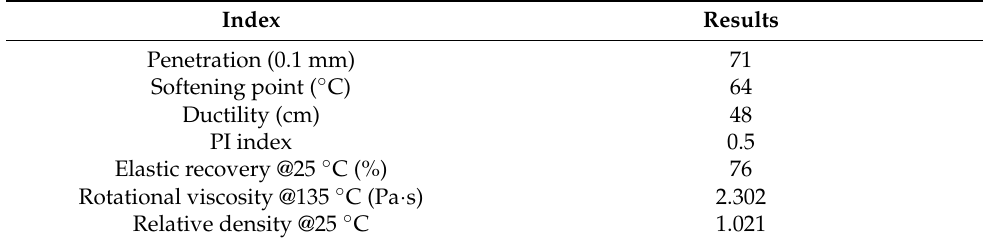
Table 1. Properties of SBS modified asphalt.